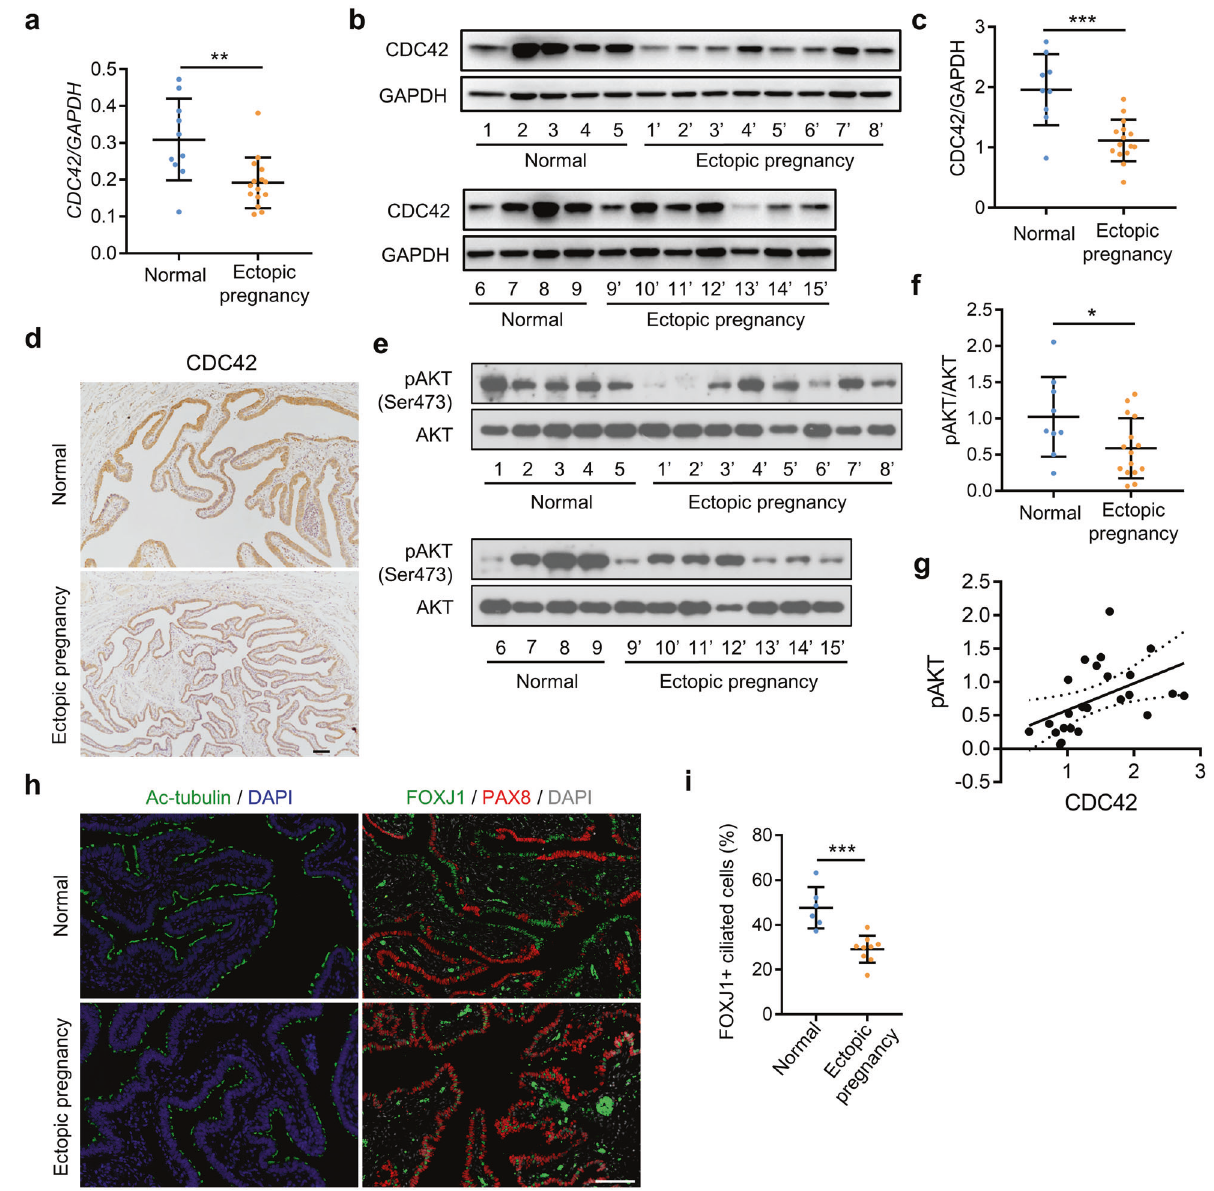
tubes from women with ectopic pregnancy ( n = 15) and normal control ( n = 9). g Correlational analysis of the protein levels of phosphor-AKT and CDC42 in all the fallopian tubes ( n = 24) including women with ectopic pregnancy ( n = 15) and normal control ( n = 9). h